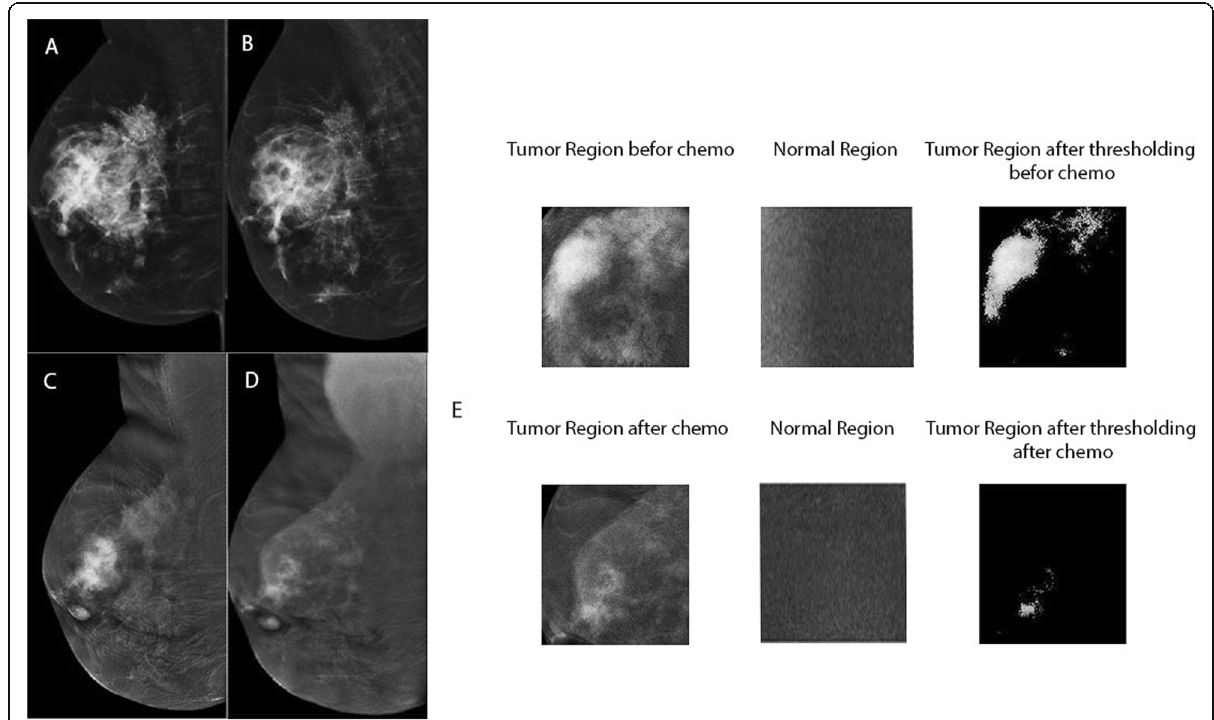
Fig. 7 A 47-year-old patient with IDC of the right breast. Biomarker status of the tumor was ER-positive, PR-positive, and HER-2 positive. a Pre NAC mammogram MLO view showing right breast UOQ speculated mass with micro-calcific clusters. b Post NAC mammogram MLO view showing mild decrease of the size of the mass. c Pre NAC CESM MLO view separated lesions; multi-centric masses. d Post NAC CESM CC view showing residual multi- nodular lesions. e Quantitative mathematical objective evaluation showed 84% percentage of regression. Combined evaluation response classified this patient as moderate response with 30 – 60% decrease in longest dimension of the dominant mass and decrease in intensity (partial responder). RECIST 1.1 classified her as partial responder. Pathological evaluation confirmed this patient as a pathological responder (Miller – Payne grade